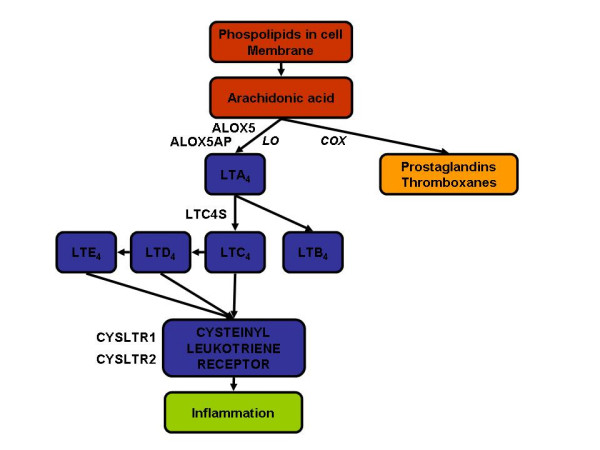
Arachidonic acid metabolism. Candidate genes selected for genotyping are indicated along the cysteinyl leukotriene metabolic pathway. LO, lipoxygenase pathway; COX, cyclo-oxygenase pathway; ALOX5, arachidonate 5-lipoxygenase; ALOX5AP, arachidonate 5-lipoxygenase-activating protein; LTC4S, leukotriene C4 synthase; CYSLTR1, cysteinyl leukotriene receptor 1; CYSLTR2, cysteinyl leukotriene receptor 2. Cysteinyl leukotriene metabolites are leukotriene B4 (LTB4), leukotriene C4 (LTC4), leukotriene D4 (LTD4), and leukotriene E4 (LTE4).